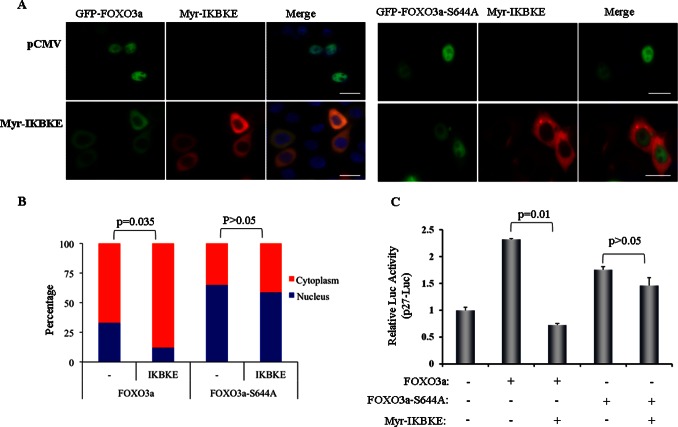
Expression of IKBKE results in nuclear-cytoplasmic translocation and loss of transcription activity of FOXO3a but not FOXO3a-S644A.(A and B) Expression of constitutively active IKBKE induces FOXO3a but not FOXO3a-S644A nuclear-cytoplasmic translocation. MCF7 cells were transfected with indicated plasmids. After 48 h of transfection, cells were stained with Alexa Fluor® 555 conjugated (red) Myc antibody and DAPI (A). Scale bar is 25 µm. Cellular localization of FOXO3a was quantified by counting 400 cells (B). (C) IKBKE inhibition of FOXO3a transcription activity depends on phosphorylation of Ser644. MCF7 cells were transfected with pGL3-p27-Luc, FOXO3a or FOXO3a-S644A together with and without myr-IKBKE. Luciferase assay was performed after 48 h of transfection as described in Figure 1.